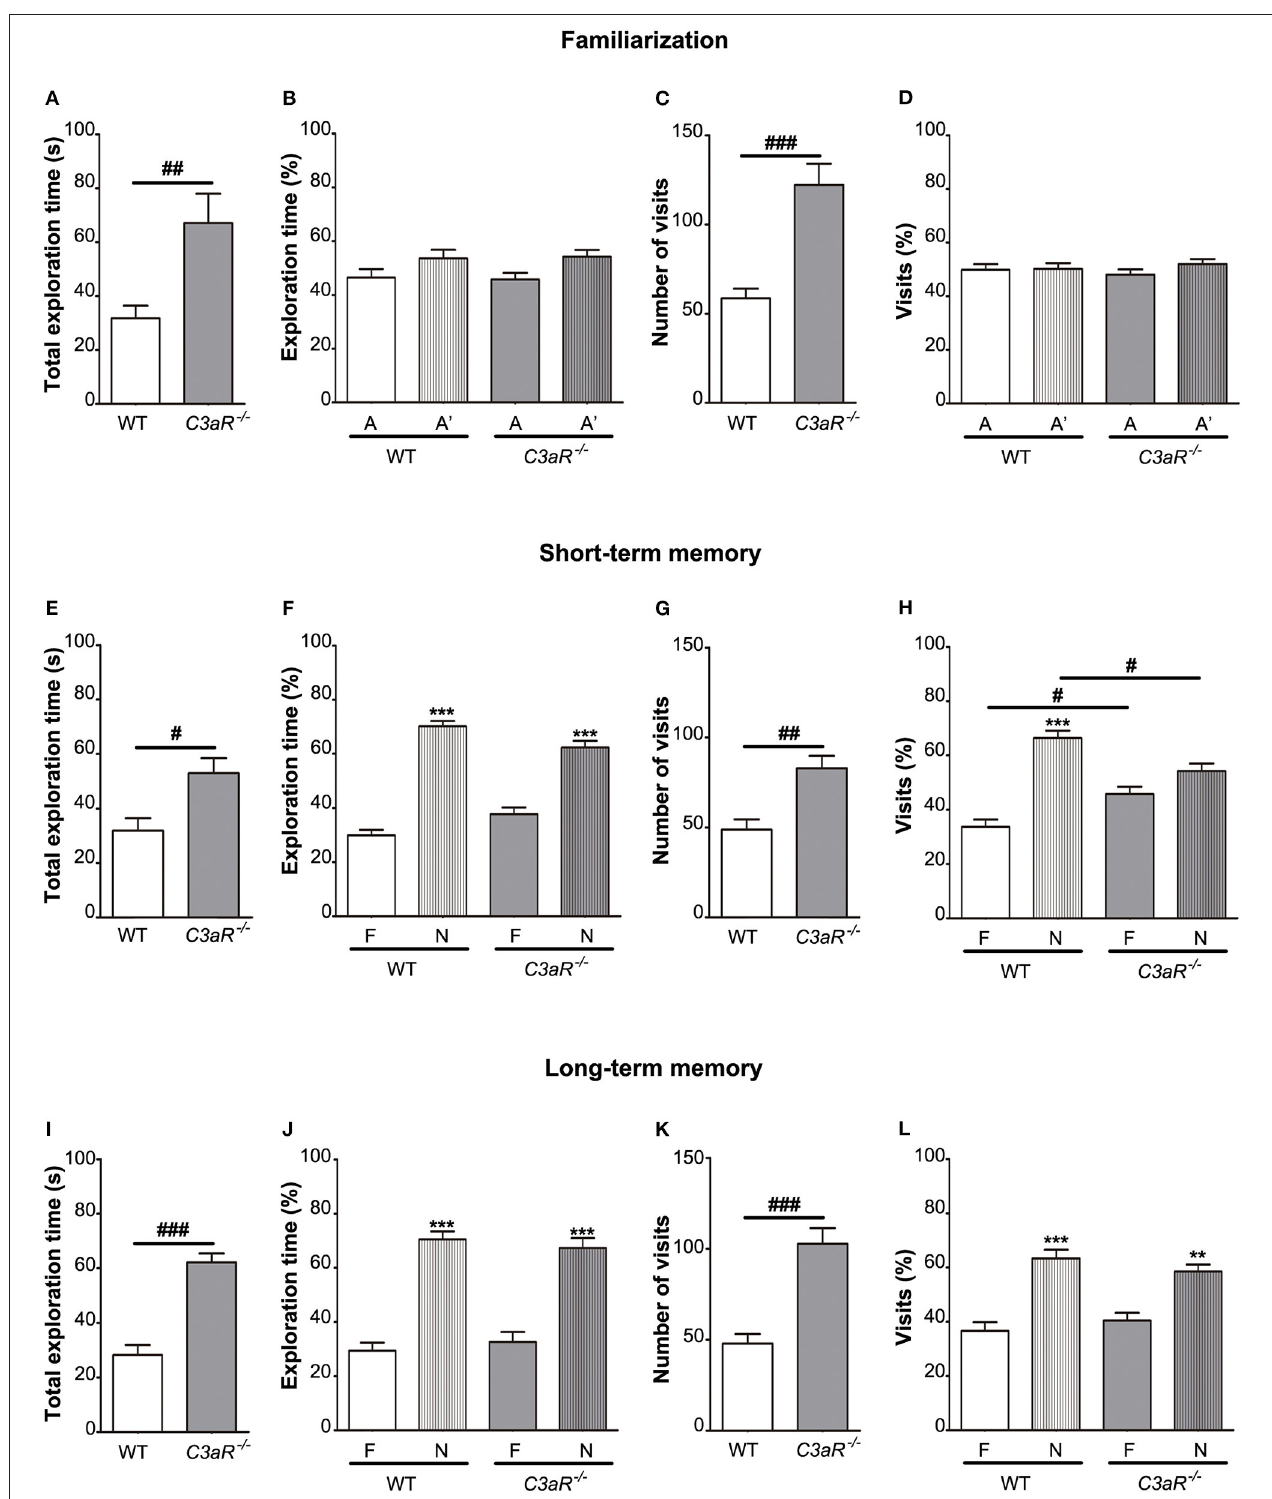
FIGURE 2 | C3aR − / − mice have impaired short-term memory. Object recognition test assessment of short and long-term memory. (A) time spent exploring individual objects, (B) relative exploration time, (C) number of visits, and (D) relative visitation of the objects during familiarization, short-term memory testing 6h later (E–H) and long-term-memory testing 24h later (I–L) . A, A ′ , identical objects used during the familiarization phase; F, familiar object; N, novel object used during the testing